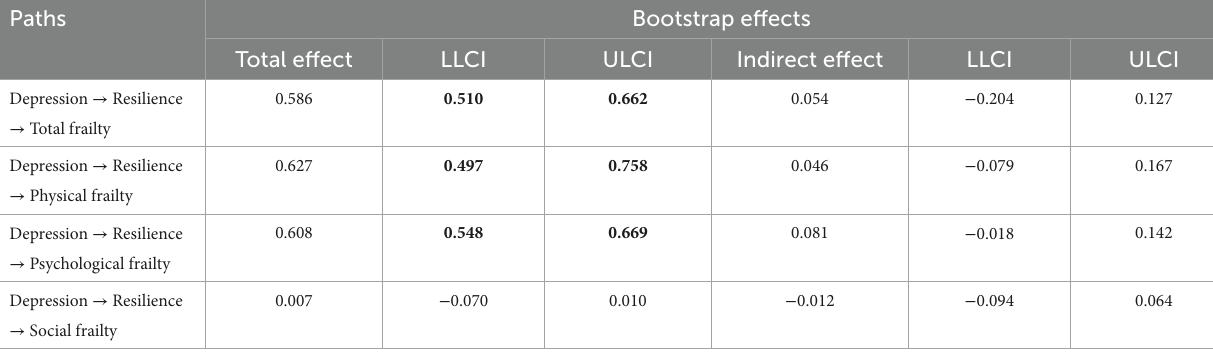
TABLE 4 Results of mediating effect for resilience between depression and frailty.